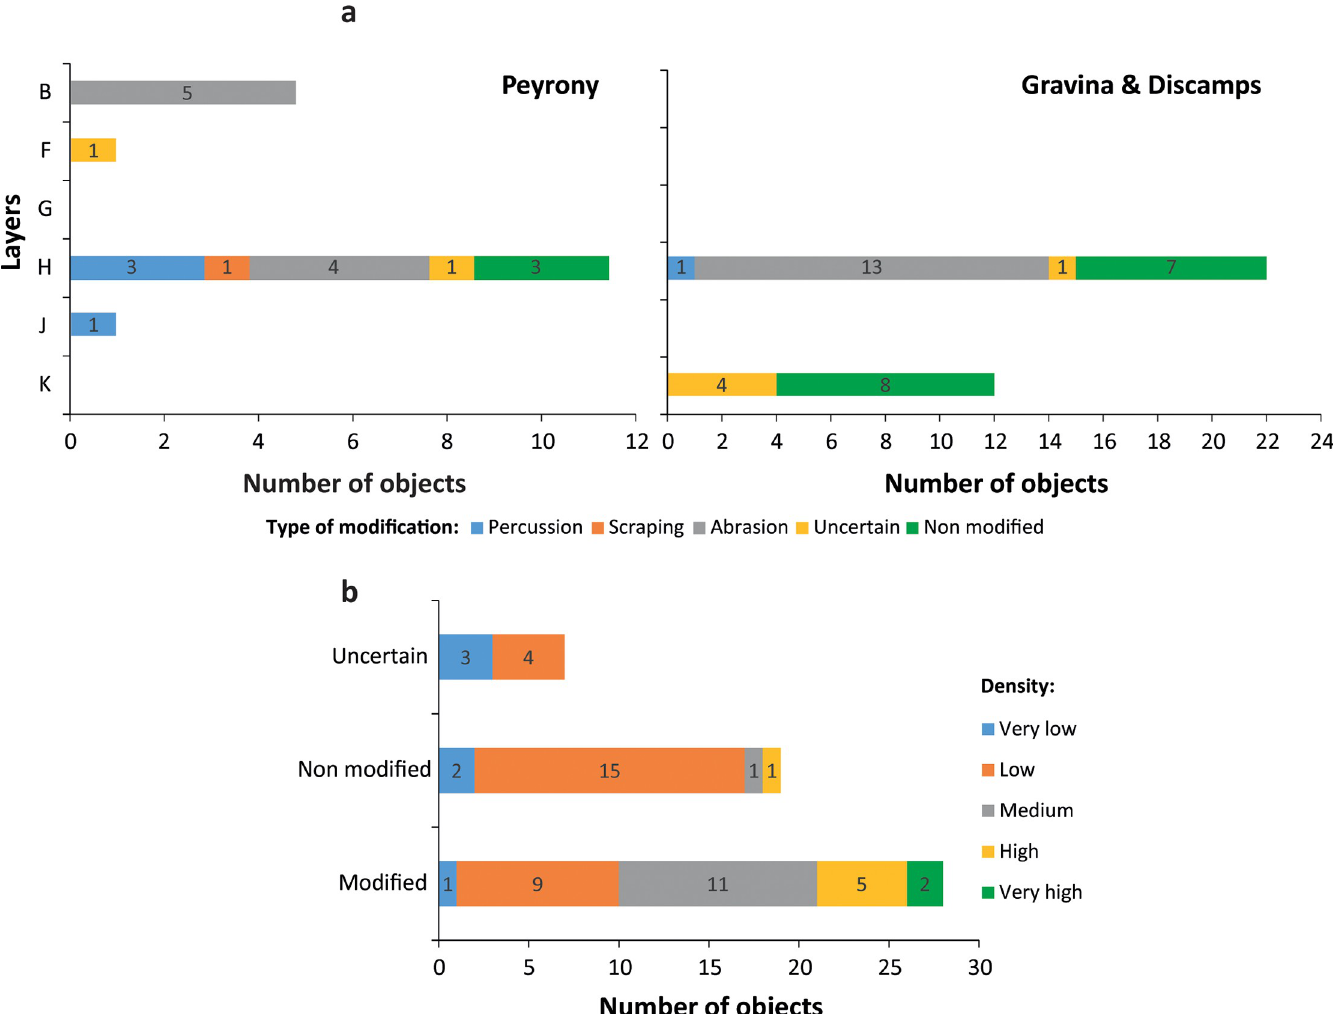
Fig 4. Modification types. Types of modification identified on manganese-rich lumps from Le Moustier by layer (a) and density (b). The arrow indicates the point of impact.